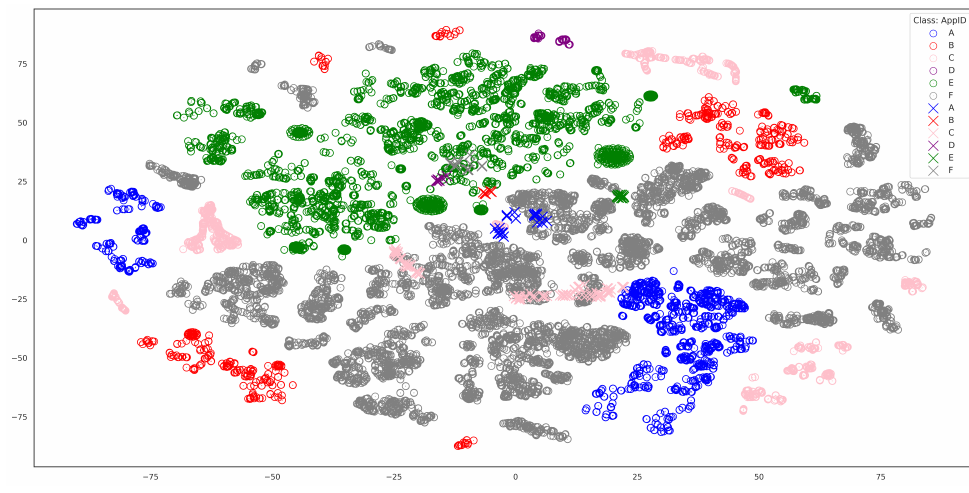
Figure 4. Visualizing unique security alert samples using t